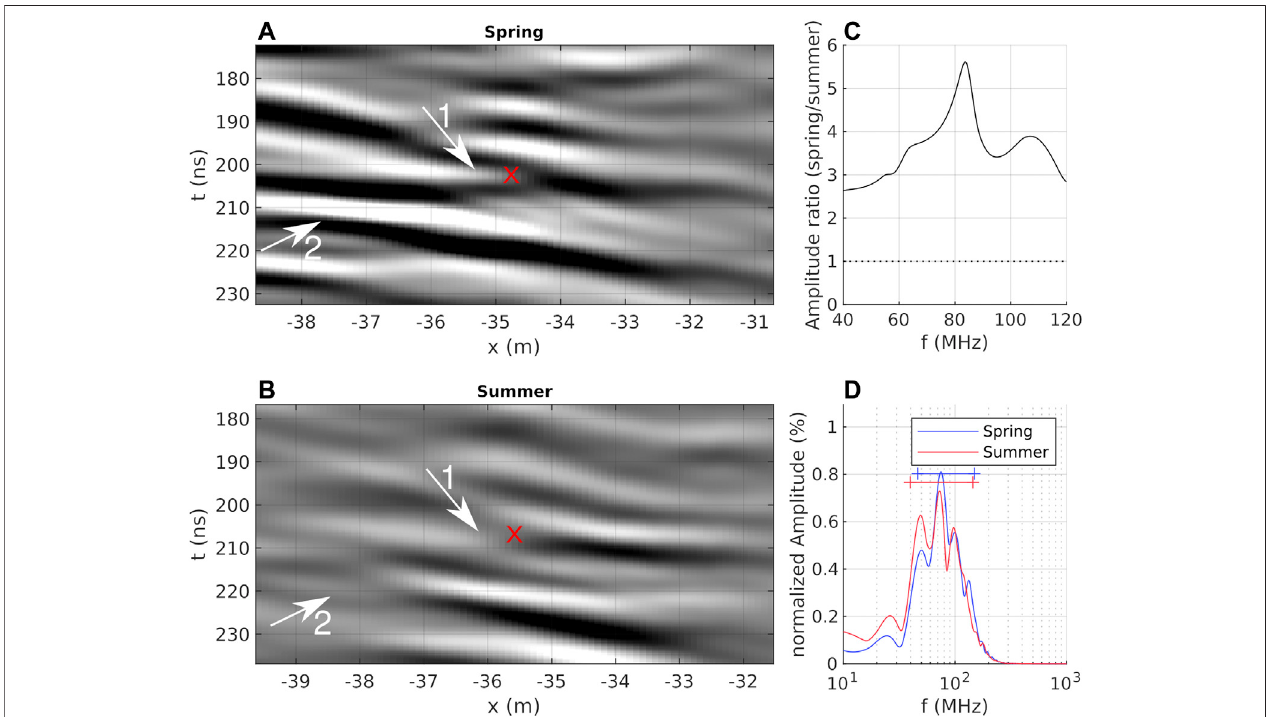
FIGURE 9 | Exemplary 2D detail in time (A,B) and frequency domain (C,D) . 2D data were extracted from our migrated (A) spring and (B) summer data cube (betweenx= − 39and − 31 m,aty=21 m),andmanuallyalignedbasedonimagedetails(redmarkeratcenter).Note,againfactoroftwohasbeenappliedtothesummer data for visualization. Right column: (C) ratioof unnormalized amplitude spectra around ournominal antenna frequency and (D) normalized amplitude spectra for spring (blue)andsummer(red) data.In (D) ,horizontallines denotefrequencyrangebetween10thpercentileA 10 and90thpercentile A 90 (comprising80%oftherecorded amplitudes). Arrows identify features that are further discussed in the text.